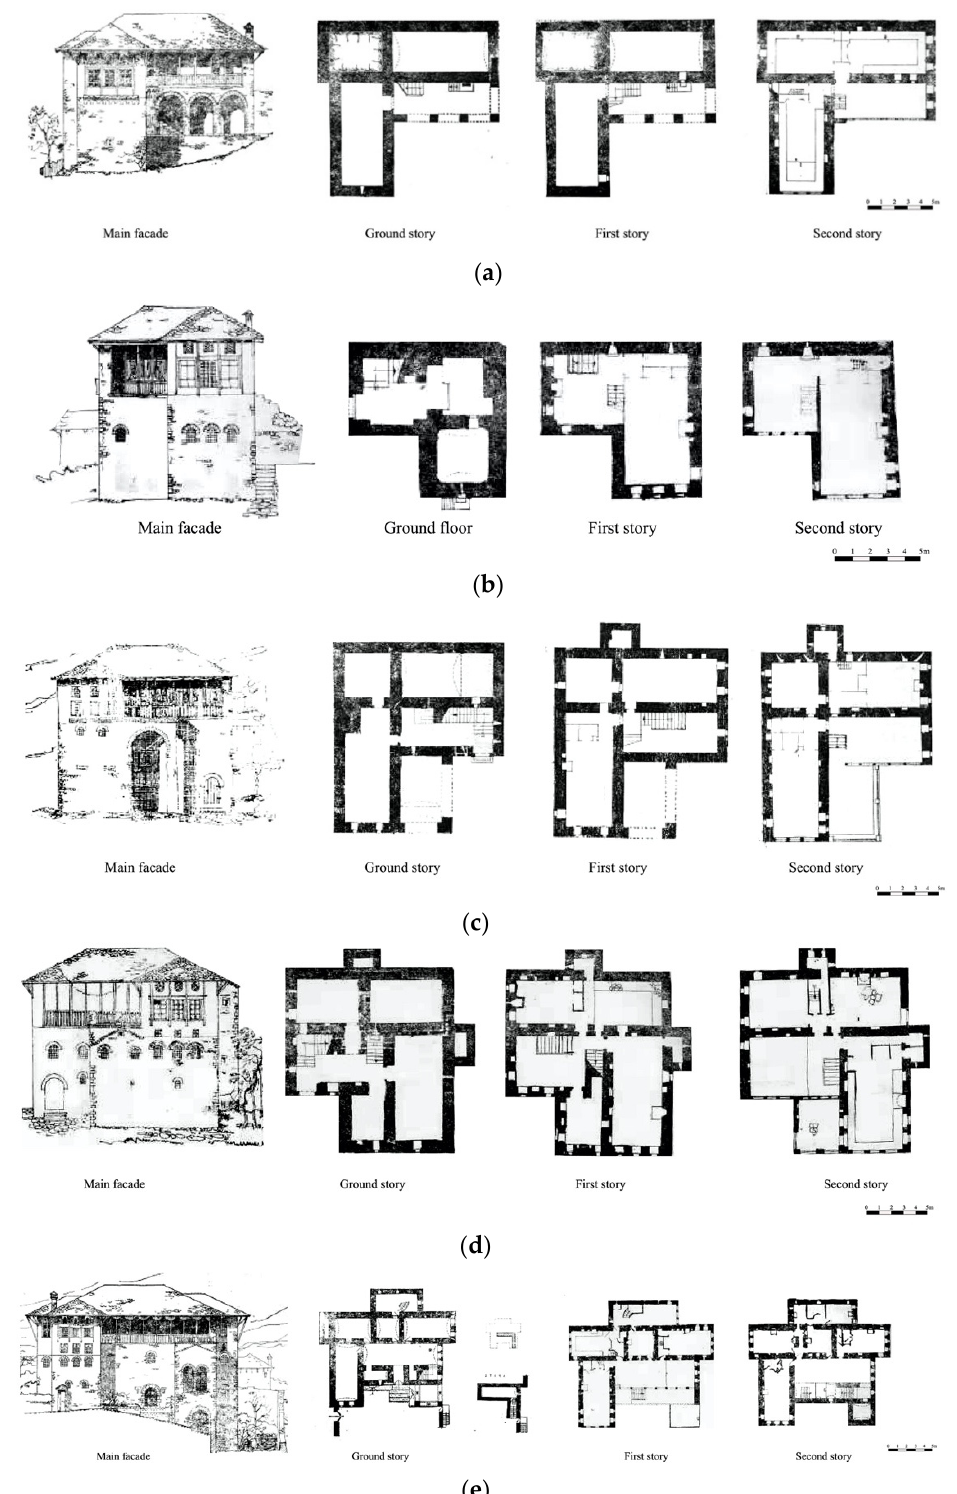
Figure 5. Examples of the single-wing building located at: ( a ) P. Xhixho St, n.15; ( b ) A. Toro St, N.20; ( c ) K.Bako St, n.17; ( d ) M. Bakiri St, n.45; ( e ) A. Frasheri St, n.6 (adapted from [3]).